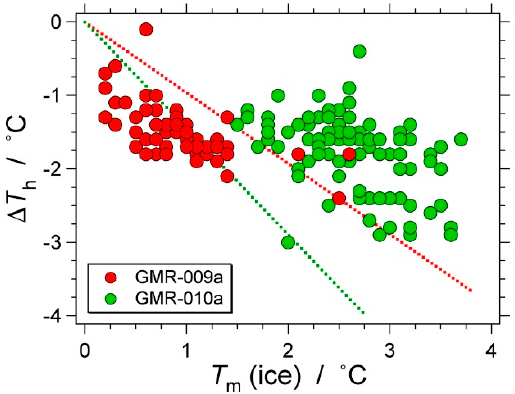
Figure 14. Modification of T h ( Δ T h ) versus T m of individual fluid inclusions after the re-equilibration experiments GMR-009a (red symbols) and GMR-010a (green symbols). The dashed lines represent the ideal mixing behavior of H 2 O and D 2 O for both experiments.